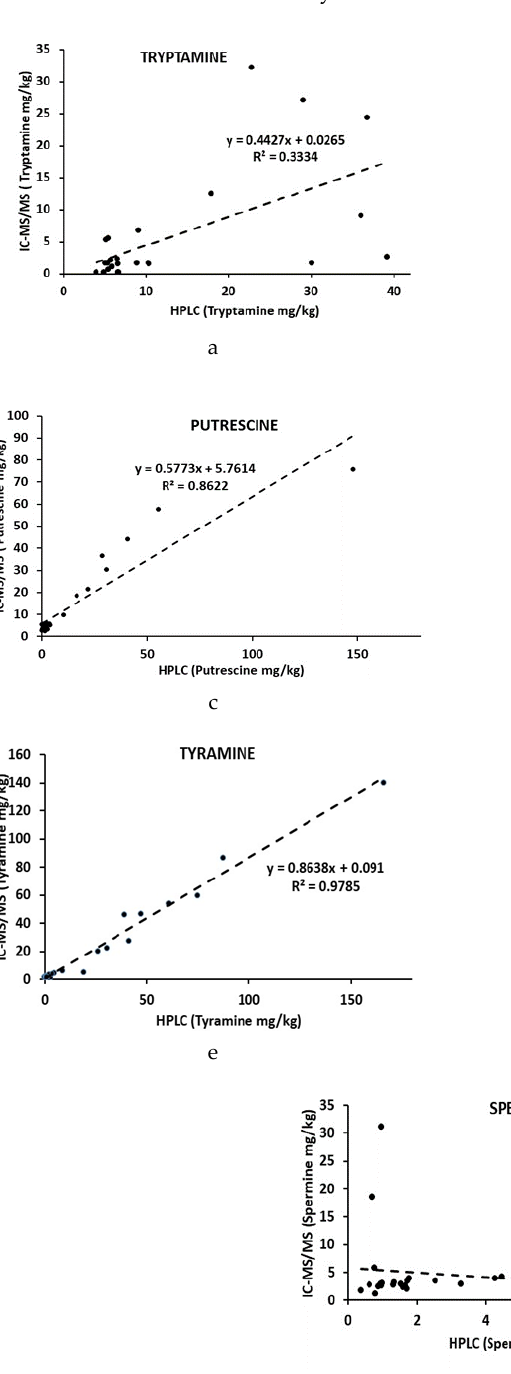
Figure 4. Correlation results between the IC-MS/MS and HPLC methods in determining seven biogenic amines in various fish products. (( a ) Correlation results for Tryptamine; ( b ) Correlation results for Phenylethylamine; ( c ) Correlation results for Putrescine; ( d ) Correlation results for Cadeverine; ( e ) Correlation results for Tyramine; ( f ) Correlation results for Spermidine; ( g ) Correlation results for Spermine).